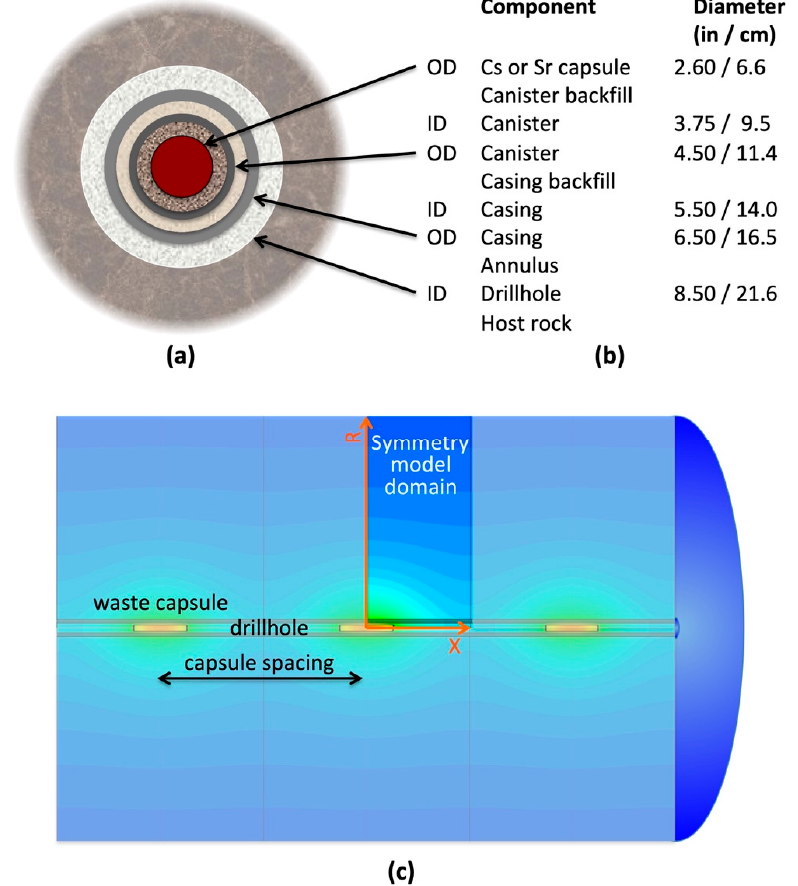
Figure 1. ( a ) Cross-sectional schematic of components in a horizontal drillhole used for the disposal of heat-generating cesium or strontium capsules; ( b ) list of inner diameters (ID) and outer diameters (OD) of each component; ( c ) X-R cross section, showing symmetric model domain.